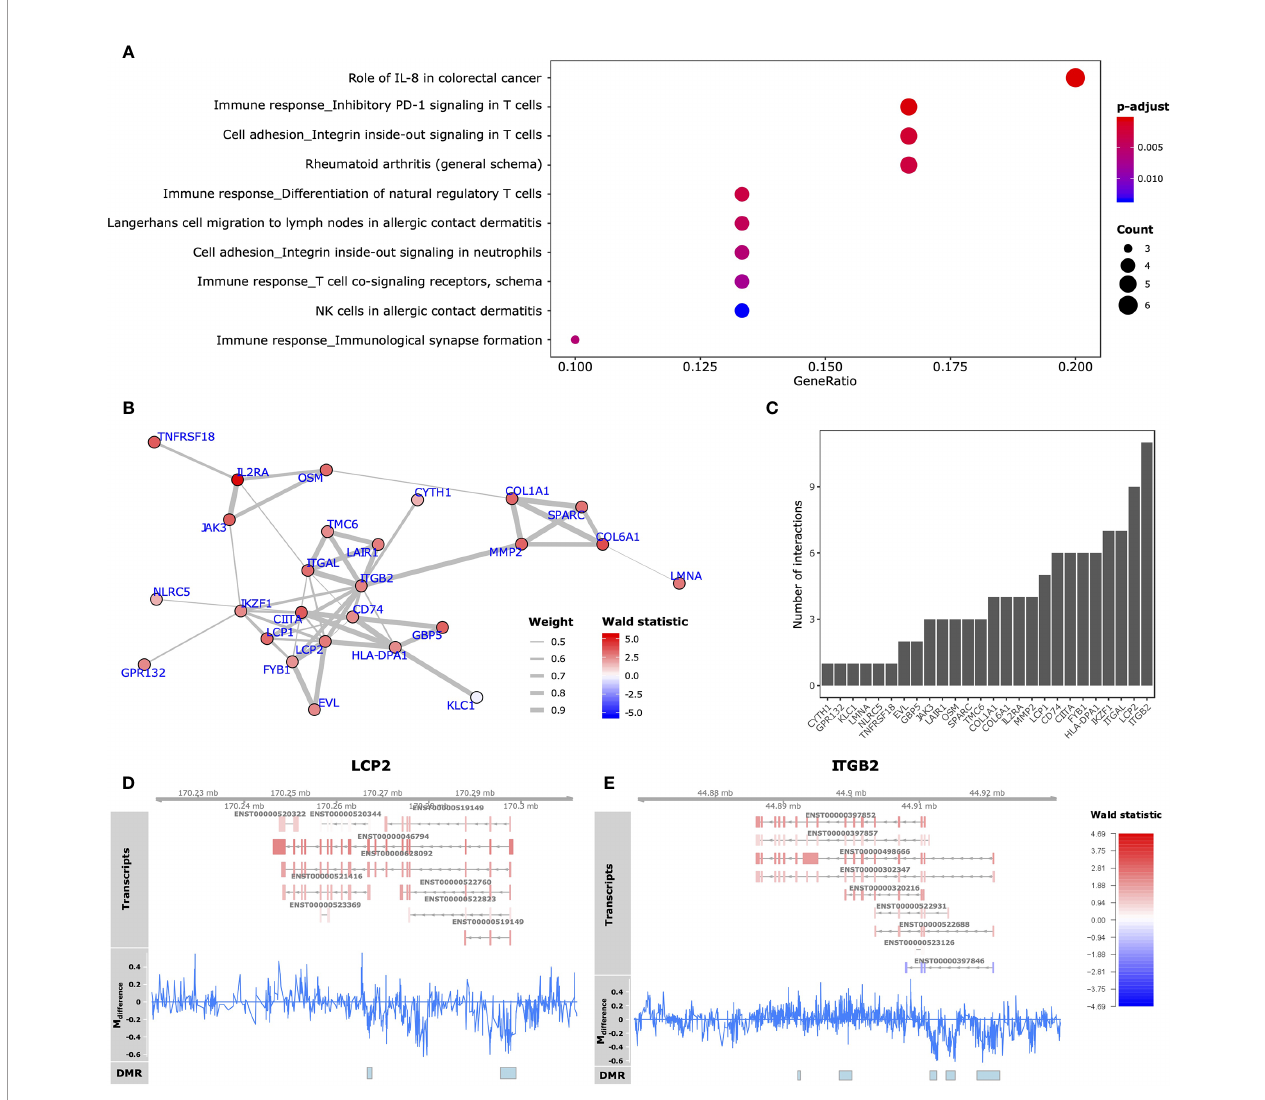
FIGURE 5 | Functional analyses GDEMs. (A) The 10 most overrepresented MetaCore gene sets found for the GDEMs depicting the ratio of pathway-associated GDEMs relative to the total number of pathway-associated genes. The size and colour intensity are proportional to the number of pathway-associated GDEMs and the -log 10 (adjusted p-values), respectively. (B) GDEMs were analysed for known interactions by querying the STRING database. Represented here is the protein- protein interaction network, where the thickness of the edge is proportional to the STRINGdb evidence score and the colour proportional to the Wald statistic, respectively. (C) Bargraph representing the number of interactions per protein. Summary visualization of the DNA methylation and gene expression signals for GDEMs: (D) LCP2, (E) ITGB2. The “ Transcripts ” track represents individual transcripts coloured by the Wald statistic. The “ M difference ” track represents the difference in percentage methylation when comparing SJC66 high with SJC66low. The “ DMR ” track represents the locations of the DMRs as found by